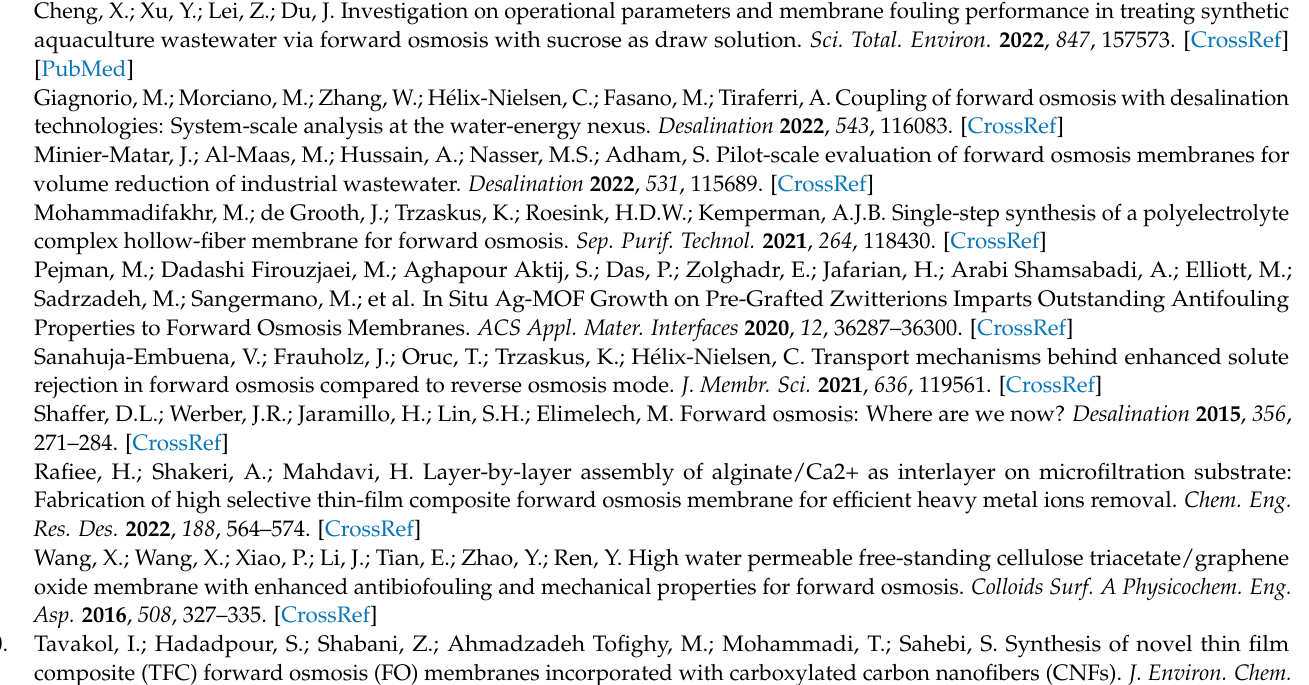
Figure S2: Specific reverse salt flux of PSU/PEG10 supported TFC-FO membranes; Figure S3: Water flux of PSU/PEG20 supported TFC-FO membranes; Figure S4: Specific reverse salt flux of PSU/PEG20 supported TFC-FO membranes; Figure S5: The preparation process images including: (a) before casting, (b) after casting, (c) after phase